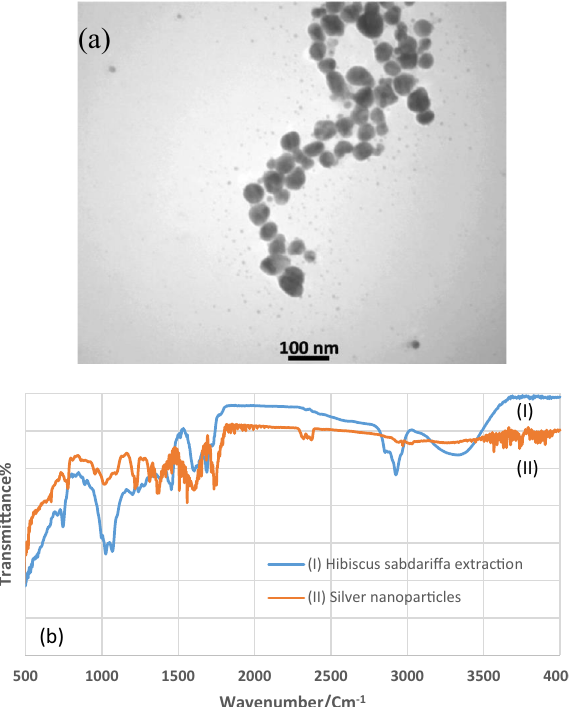
Figure 4. TEM image of synthesized silver nanoparticles using the Hibiscus sabdariffa extraction ( a ), FT-IR of silver nanoparticles, and the Hibiscus sabdariffa extraction ( b